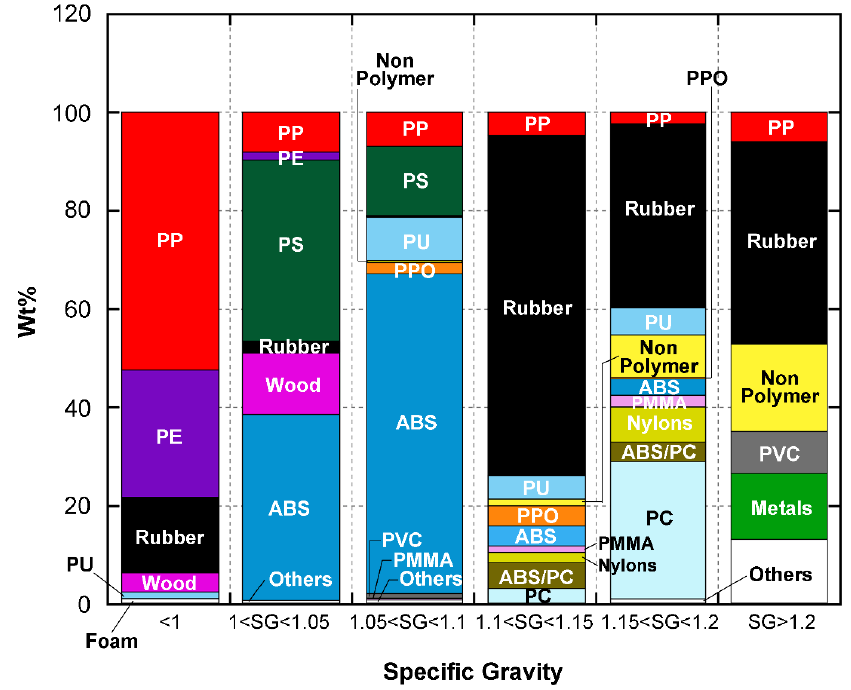
Figure 4. Flotation separation of ASR polymers.